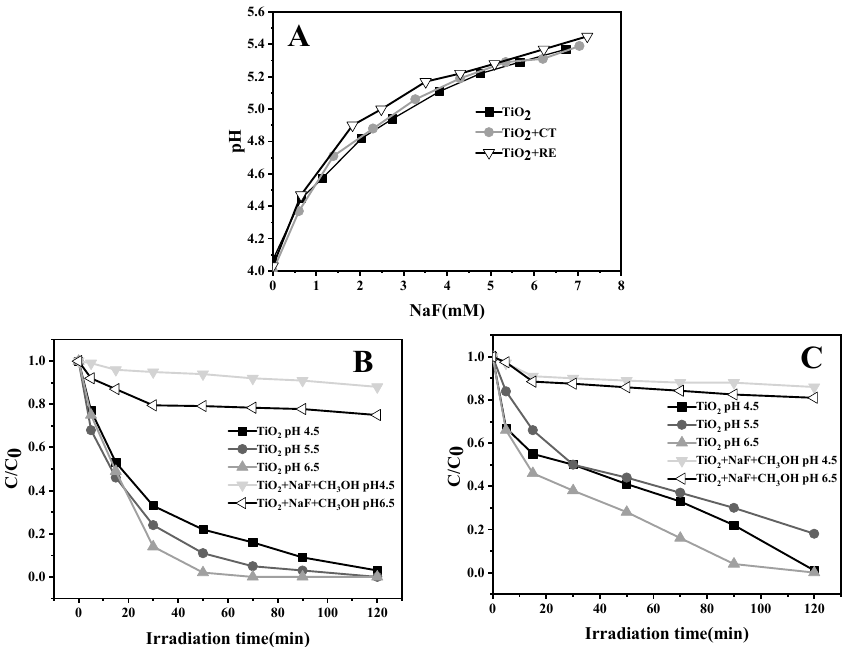
Figure 3. Effect of NaF on the pH of the reaction system ( A ). Photodegradation rate of CT ( B ) and RE ( C ) at different pH conditions.